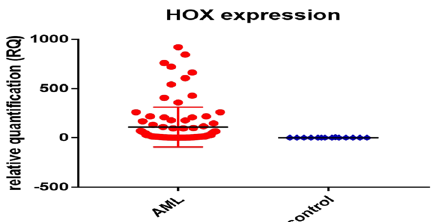
Fig. 2 Expression of HOXA9 mRNA among adult AML cases and controls